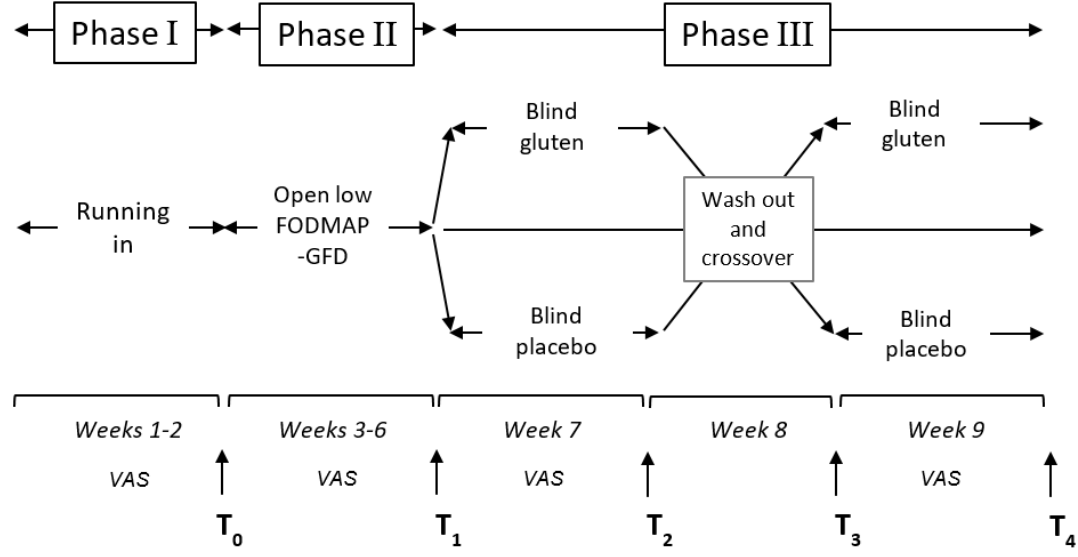
Figure 1. A detailed description of the three phases of the study.